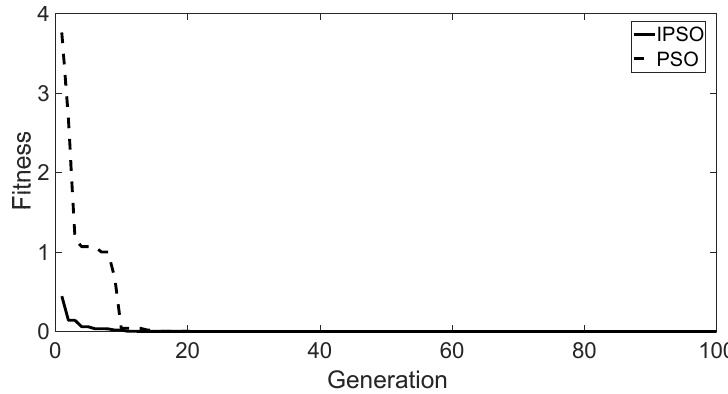
Figure 8. Fitness of Ackley function optimization.